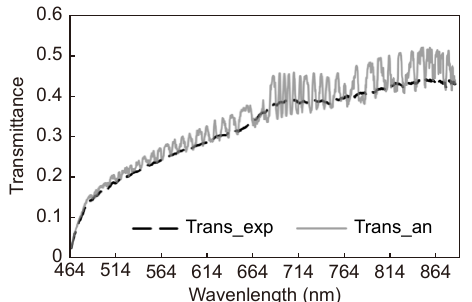
Fig. 4 | Model validation with experimental